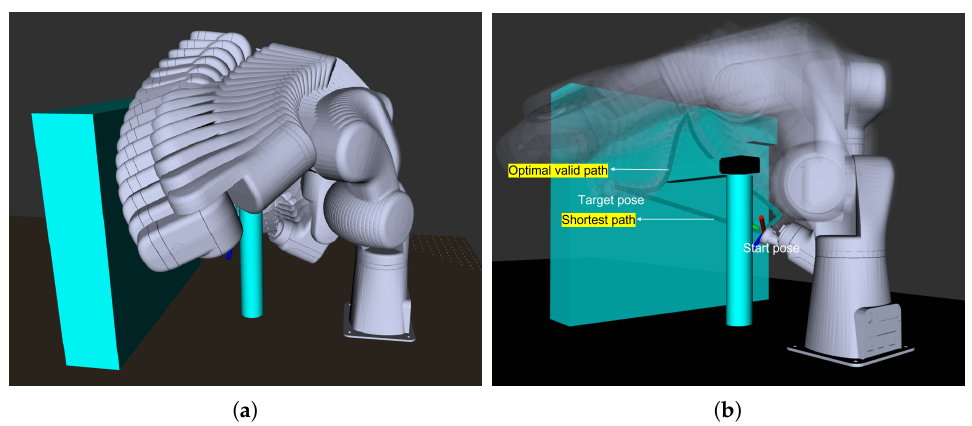
Figure 5. Planning of motion between two points with collision avoidance and optimal trajectory. ( a ) Planned sequence of the robot poses during its motion from the starting pose to the target pose. ( b ) Optimal valid path having the lowest cost vs. the shortest